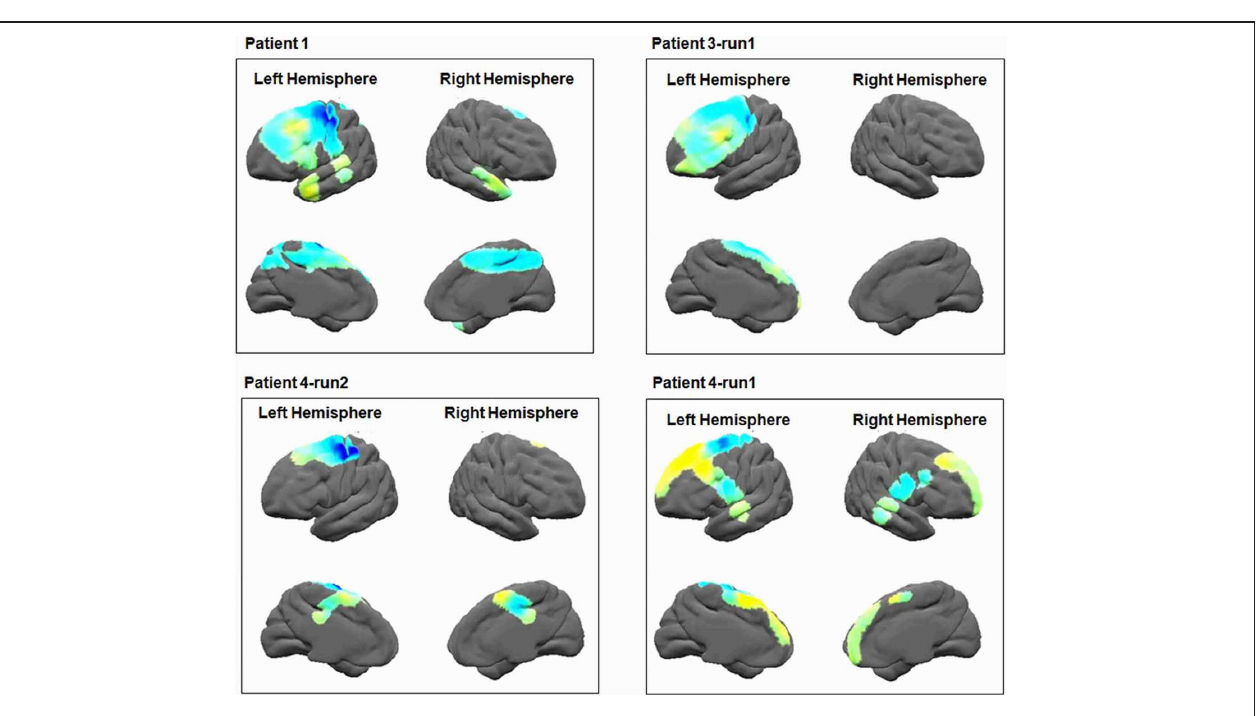
Frontiers in Human Neuroscience